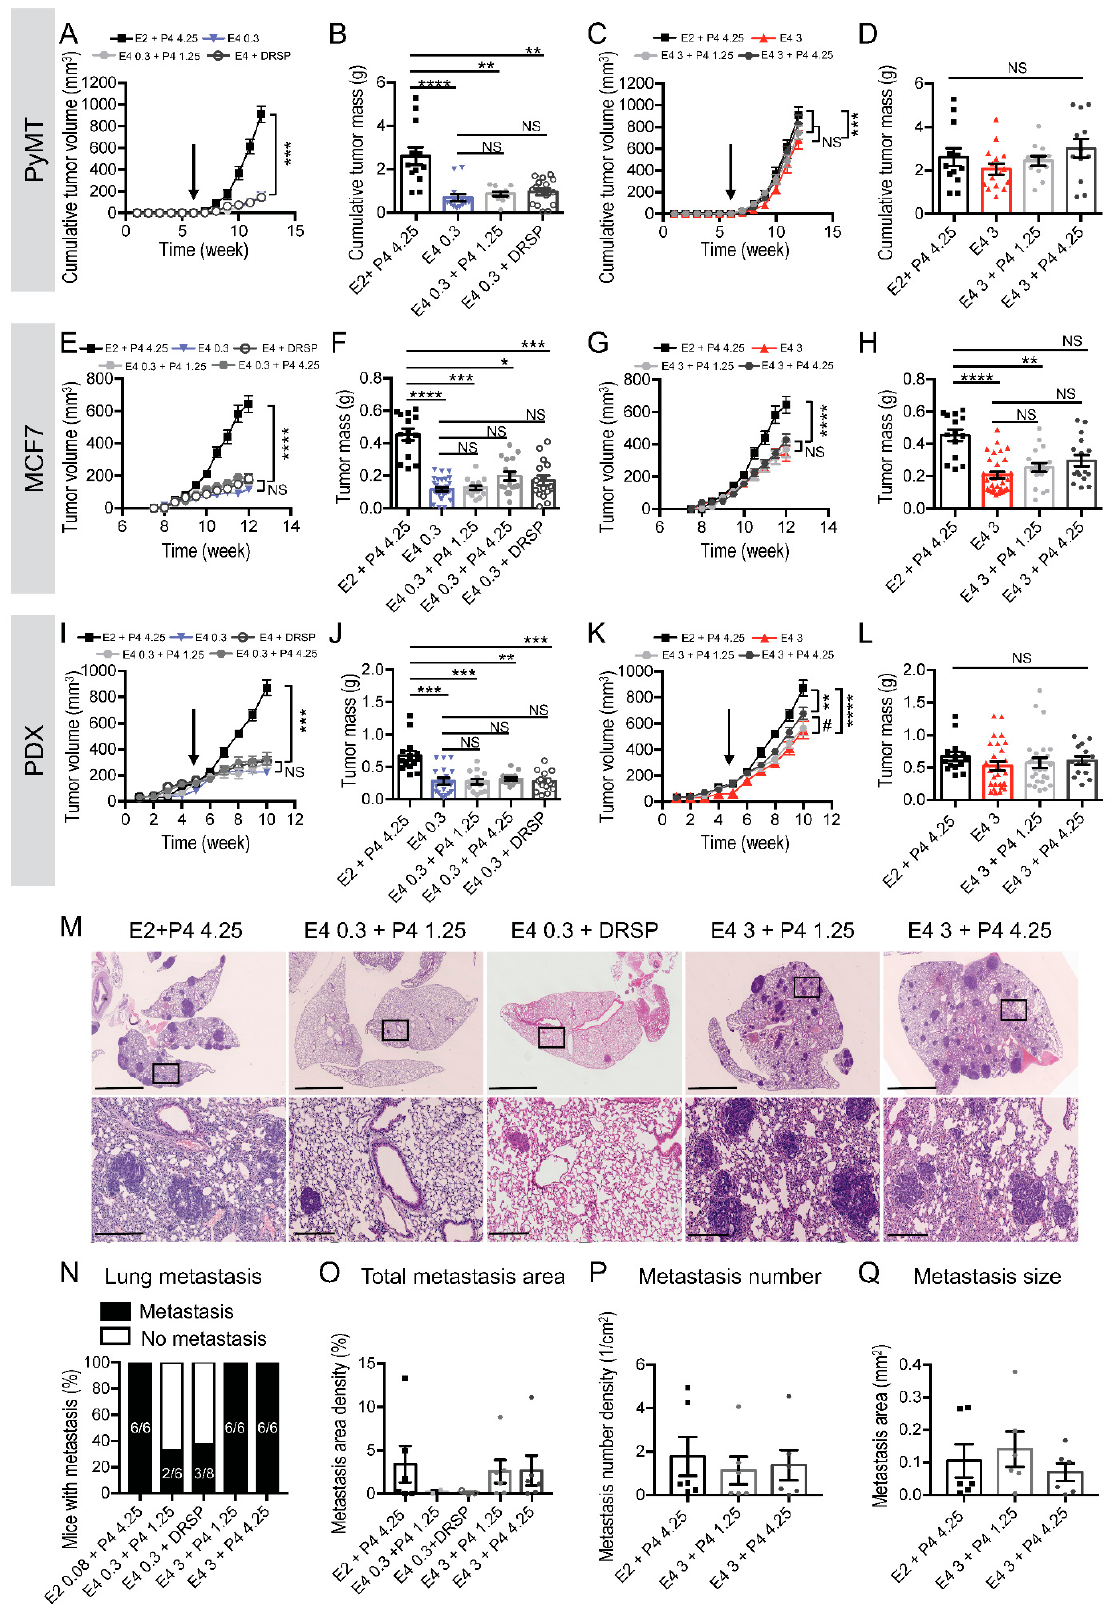
Figure 3. Dose-dependent effect of E4+progestogen on breast cancer progression . ( A ) Tumor growth kinetics (treatment start pointed by the arrow) and ( B ) tumor mass of MMTV-PyMT mice treated with E2 + P4 (4.25 mg/kg/day), E4 (0.3